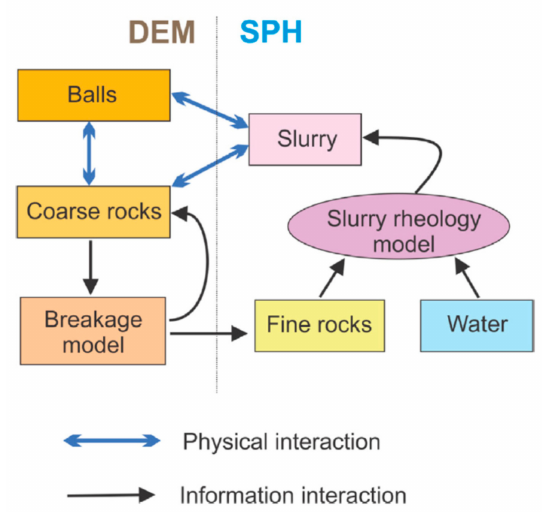
Figure 5. Example of the physical interactions, the model components, and the data flows in discrete element simulation–smoothed particle hydrodynamics (DEM–SPH) modeling of wet grinding